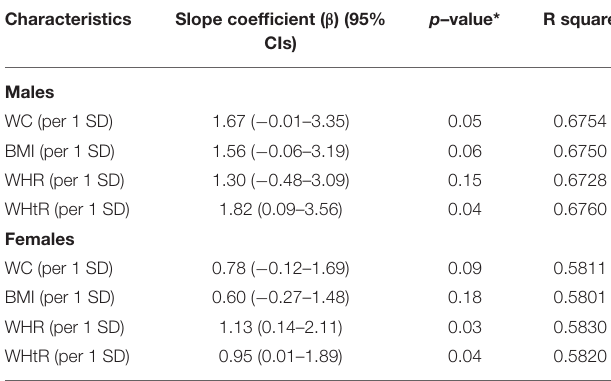
TABLE 2 | Predicted proportions of subjects with 10-year CVD risk of ≥ 10% using the Framingham Risk Score by sociodemographic characteristics. Characteristics